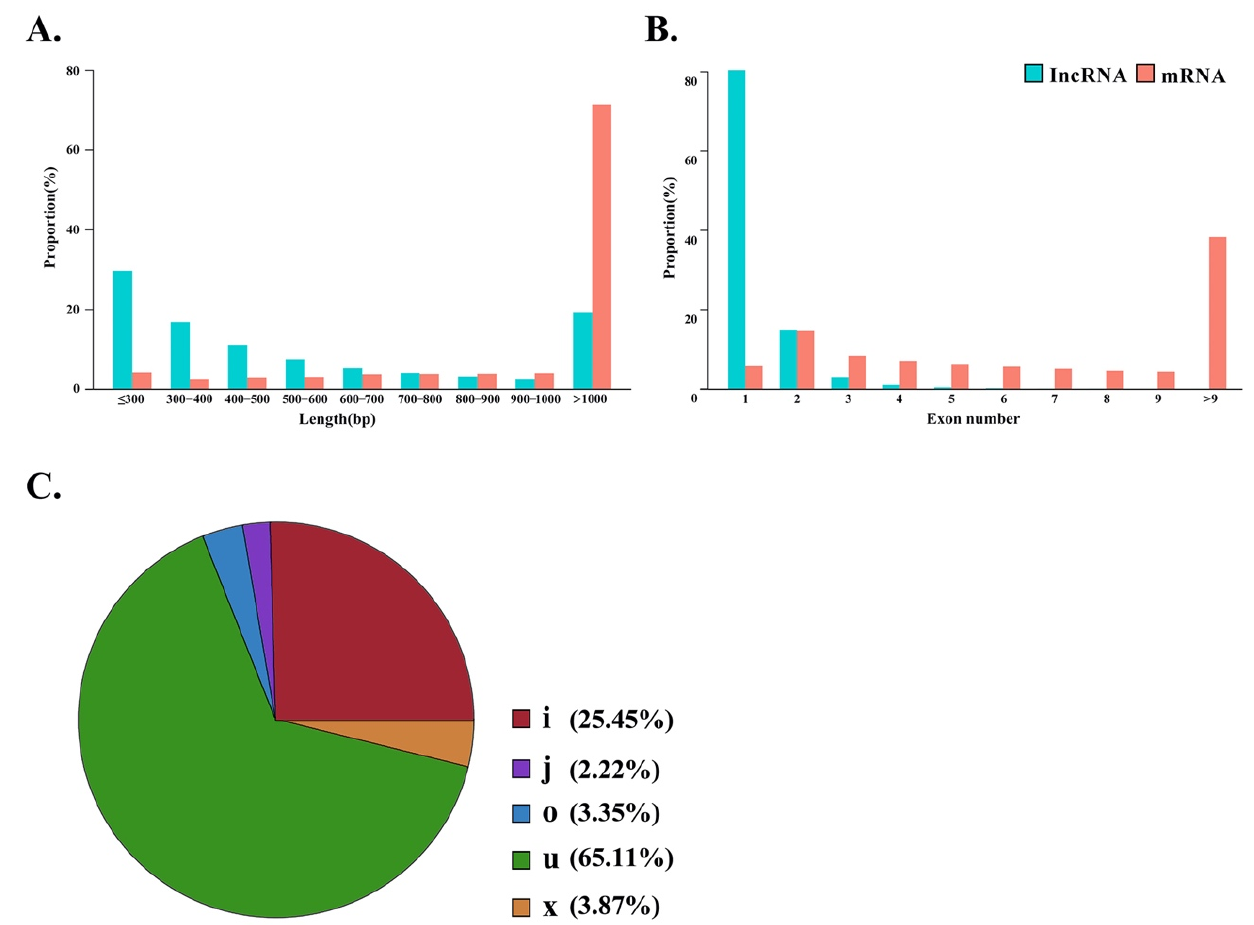
Figure 2. Comparison of lncRNAs and mRNAs in GIFT. ( A ) Length distribution of mRNAs and lncRNAs. ( B ) Number of exons in mRNAs and lncRNAs. ( C ) Pie chart of lncRNA classification groups.